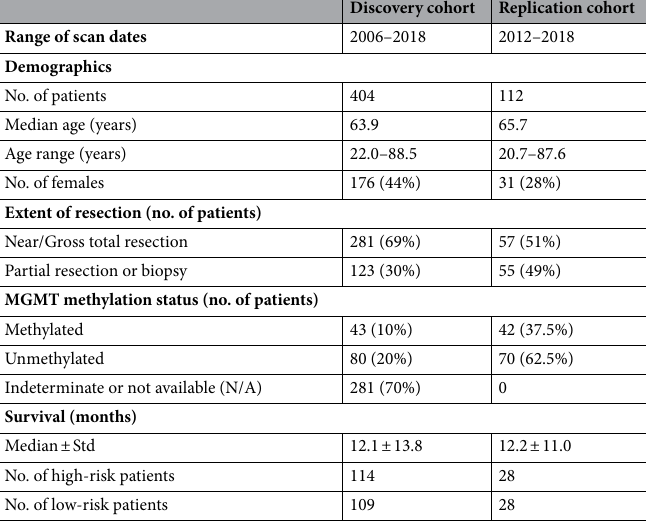
Table 1. Characteristics of the included patients in the discovery and independent replication